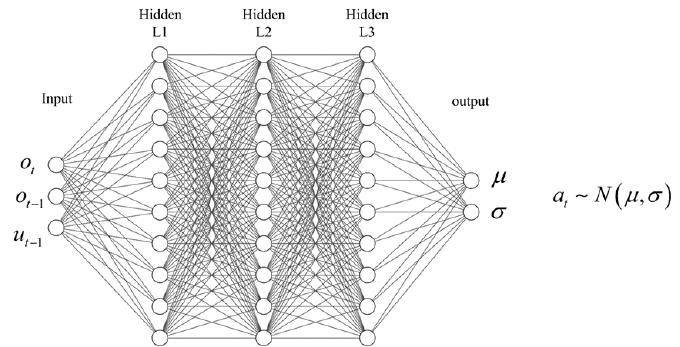
Figure 4. The structure of the actor neural network.